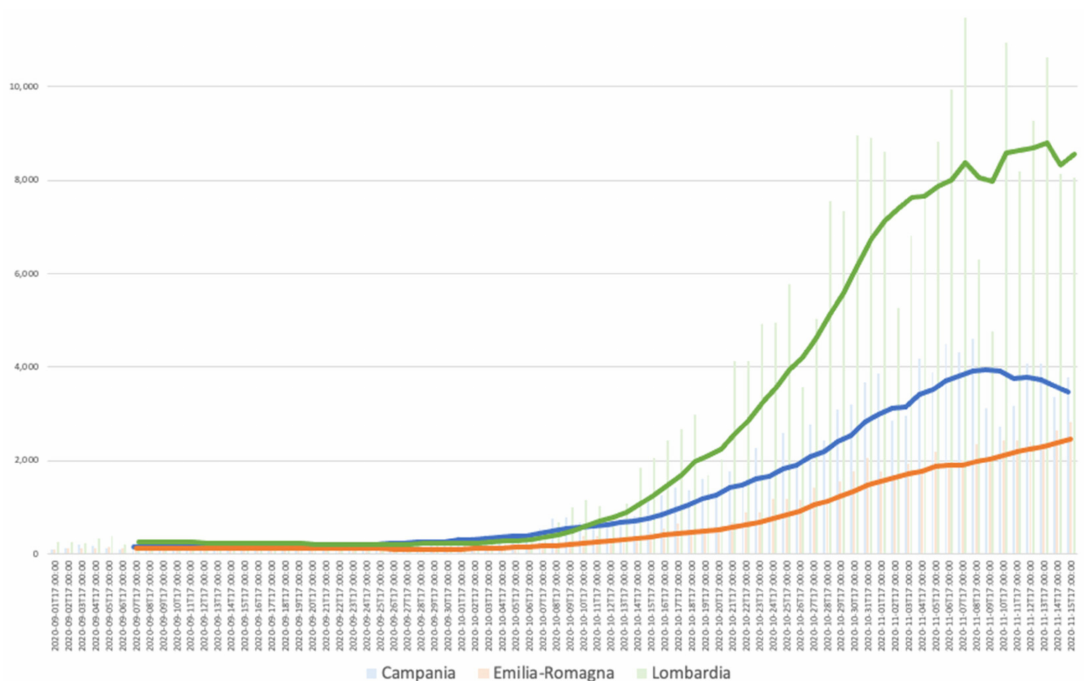
Figure 7. Daily positive new cases and 7-days avg. trend for the Italian regions: Campania, Emilia and Lombardy in the